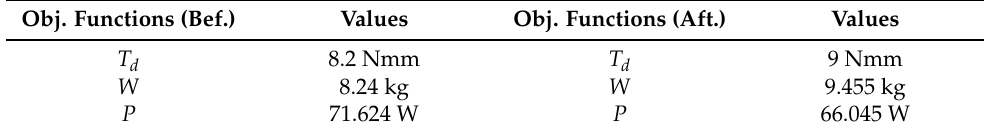
Table 10. Objective functions before and after optimization. Obj. Functions